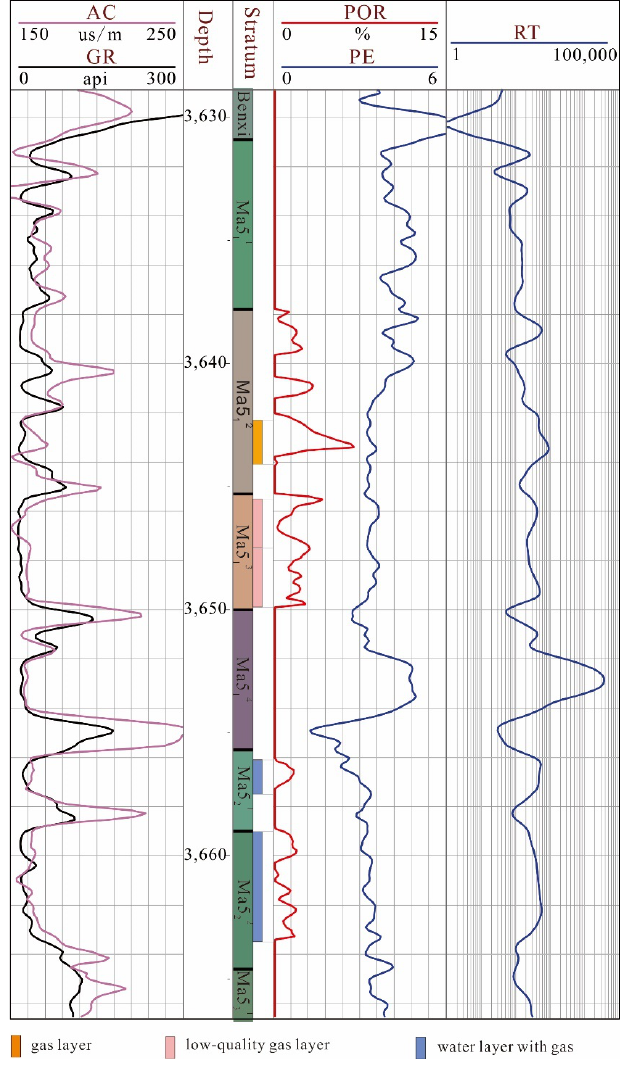
Figure 3. Typical well-log curve and its interpretation results. (Ma5 11 , Ma5 12 , Ma5 13 , and Ma5 14 represents the first, second, third, and fourth layers, respectively, of sub-member 1 of member 5, Majiagou Formation; Ma5 21 and Ma5 22 represent the first and second layers, respectively, of sub-member 2 of member 5, Majiagou Formation).